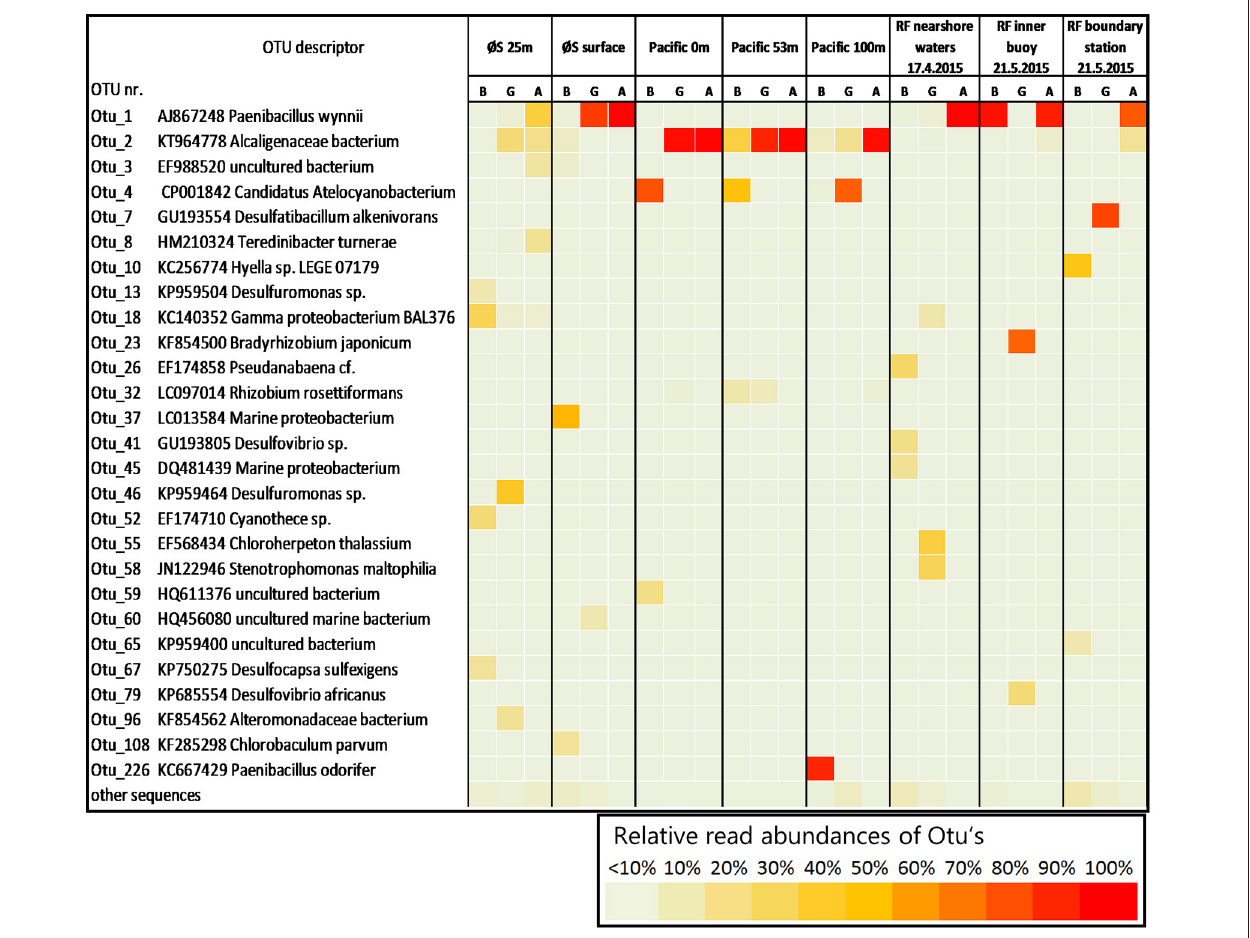
FIGURE 5 | Relative read abundances (in %) of operational taxonomic units (OTU’s) in bulk water and filtrates for the 24 samples in which BNF was measured. For clarity, only OTUs accounting for ≥ 10% of reads in a single sample are shown. Abbreviations B, G, and A refer to bulk, GF/F, and Advantec samples, respectively. The description lists accession numbers of closest BLAST hits and, where available, organism names of closest cultured or genome-sequenced organisms.